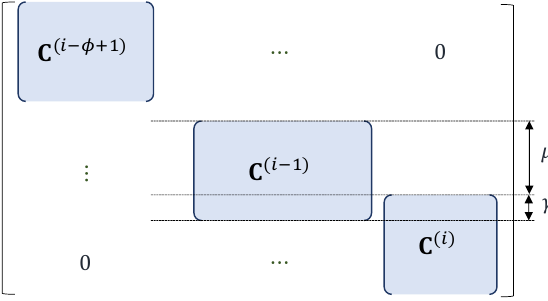
Figure 7. The form of combined coding coefficient matrix of the chain of chunks with length φ